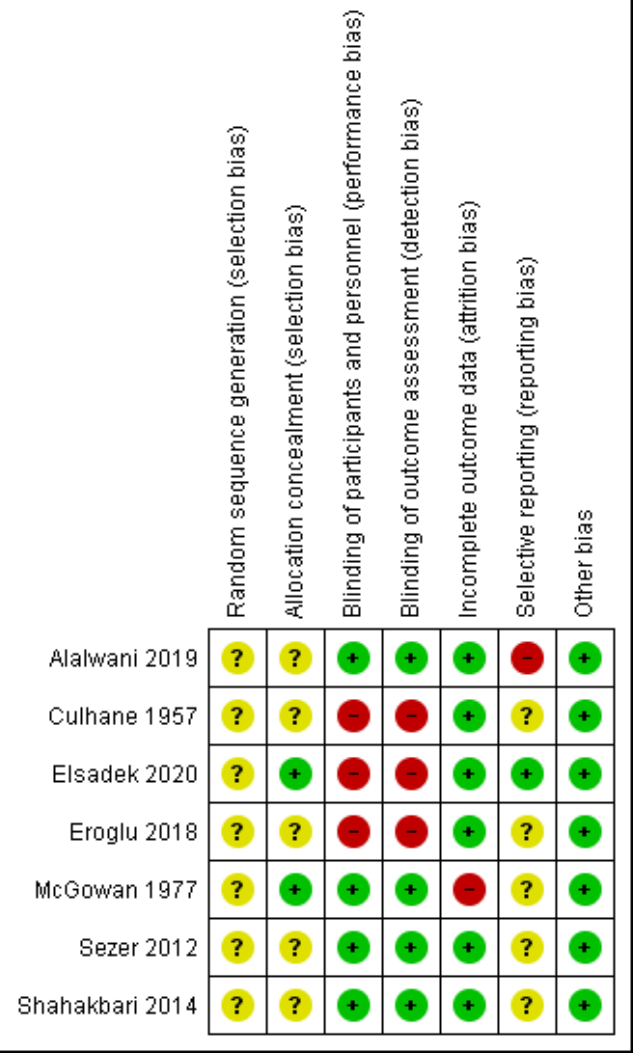
Figure 2. Summary of the risk of bias of included trials. (+) = low risk of bias; (?) = unclear risk of bias; ( − ) = high risk of bias.